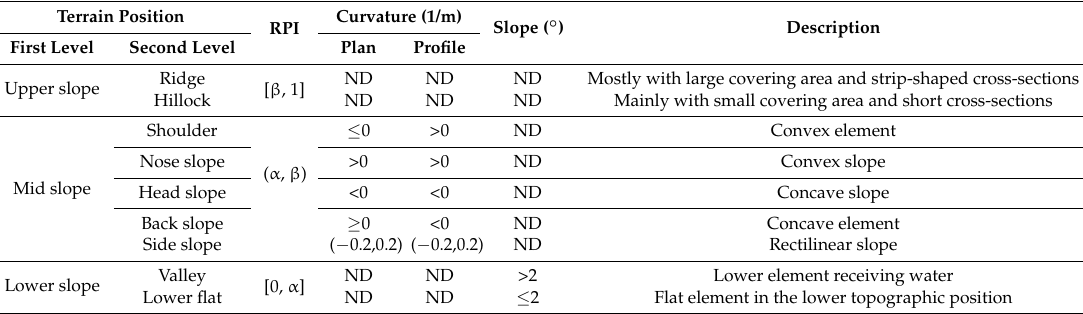
Table 1. Definition of terrain positions (ND—not